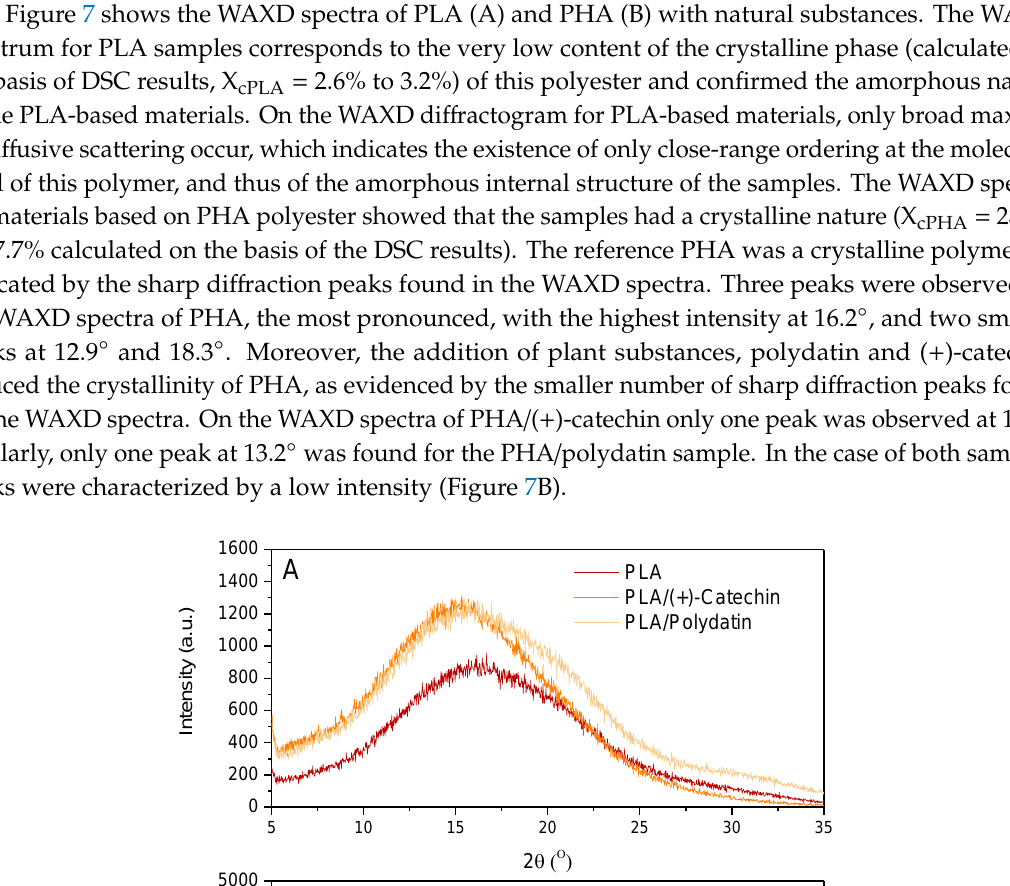
Figure 8. Surface free energy of PLA and PHA samples before and after aging. Figure 9 presents the potential of phytochemicals as dyes and indicator substances, showing the lifetime of polymeric materials. Plant-derived polyphenols are a huge group of compounds with diverse properties and are characterized by different colors, from colorless, through yellow and orange, to brown. This study shows the potential of two extreme-colored polyphenols, transparent-white polydatin and orange (+)-catechin. Polydatin did not change the color of the polymer materials, whereas the (+)-catechin gave the polyesters an orangish-yellow color. However, in the case of samples with the addition of both polyphenols, visible color changes were observed under the influence of various external factors. Figure 9 summarizes the change of color coefficients, dE·ab, with visual observations after 100, 200 and 300 hours of UV exposure (A), thermal oxidation (B), and weathering (C). It is statistically assumed that, when the coefficient of color change, dE·ab, is